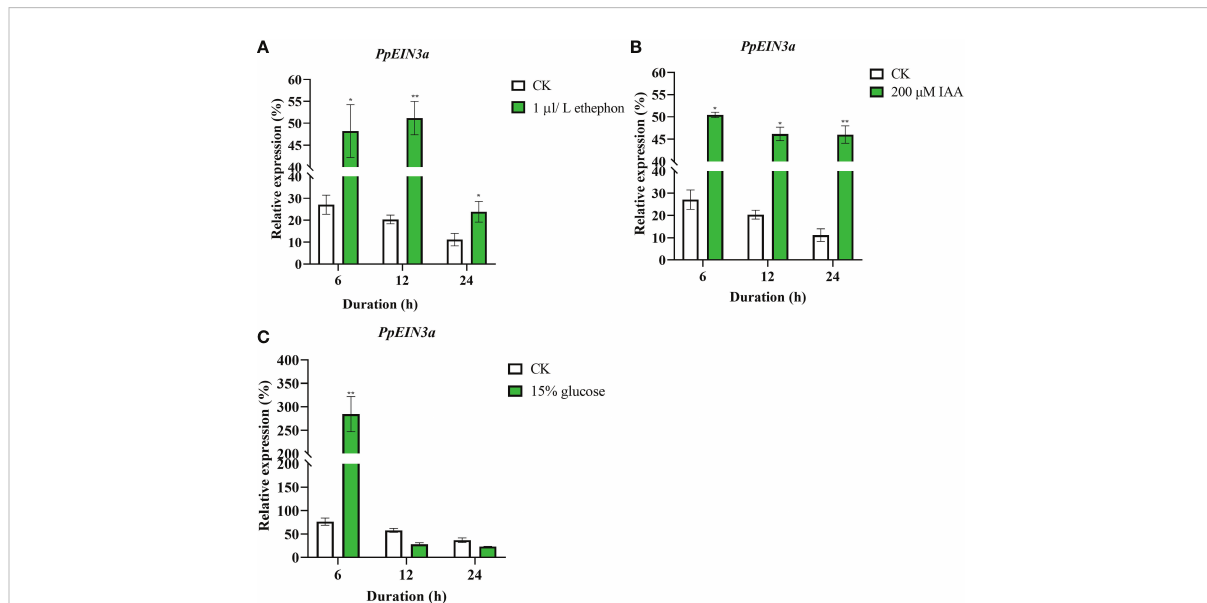
FIGURE 5 Real-time quantitative PCR analyses of the PpEIN3a expressions in the pulp of fruit under ethephon (A) , IAA (B) and glucose (C) treatments. The relative values of the PpEIN3a expressions in fruit pulp at one week after harvest that were treated with 1 m L/L ethephon, 200 m M IAA and 15% glucose are shown as the percentages of actin expression. The mean values and standard errors (bar) shown are from three independent experiments. A single asterisk shows a signi fi cant difference (* p value < 0.05), and a double asterisk represents a very signi fi cant difference (** p value < 0.01) between the treated and control pulp of fruit by t